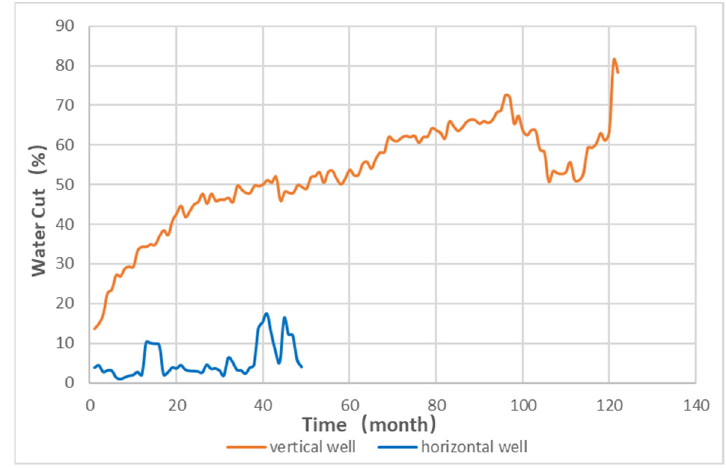
Figure 3. Comparison figure of average water cut between vertical wells and horizontal wells in A reservoir.